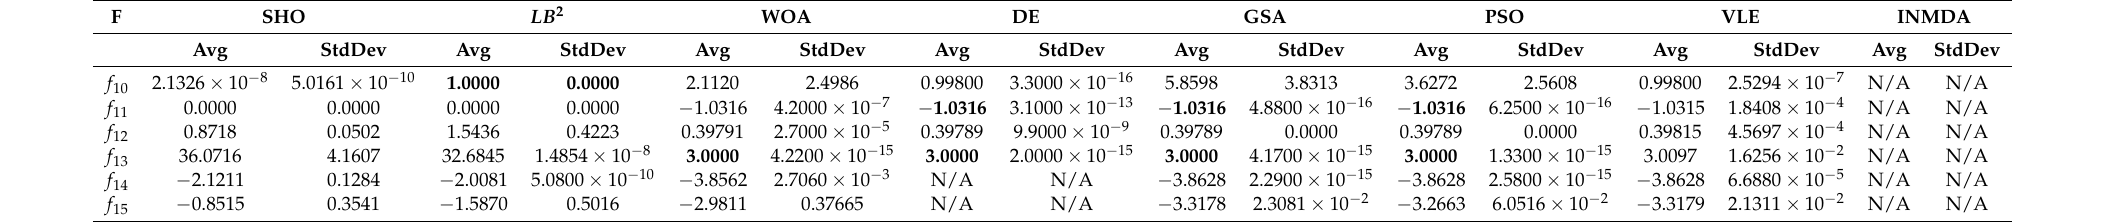
Table 8. Results comparison in multimodal benchmark functions with fixed-dimension.